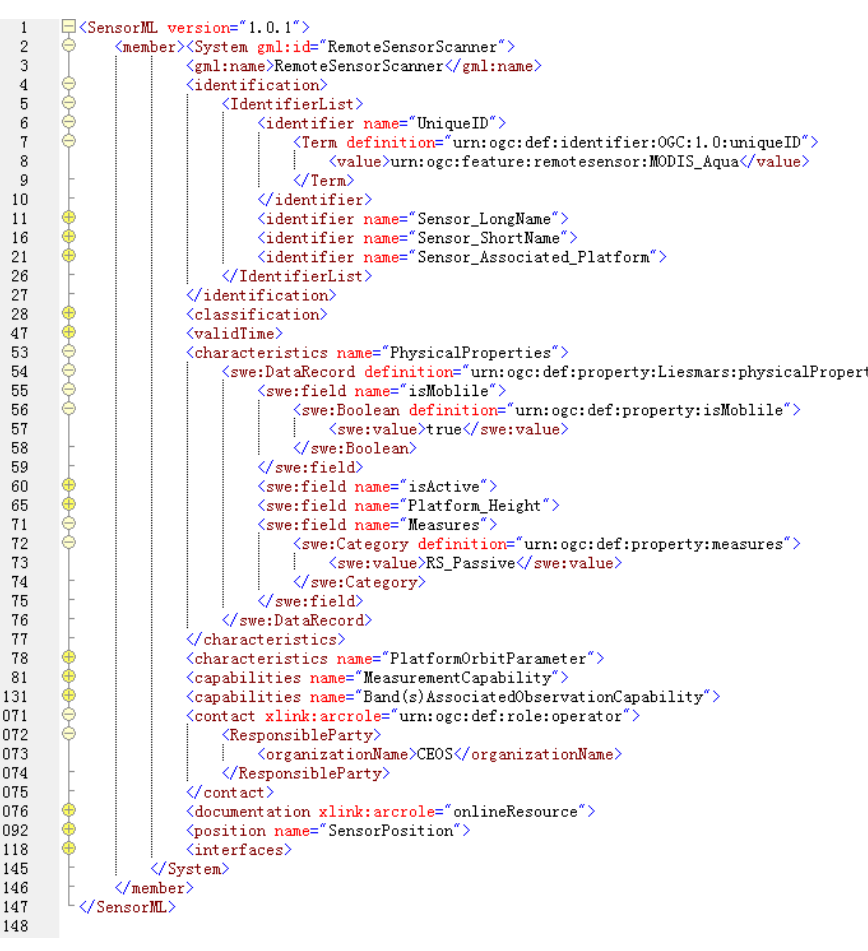
Figure 3. Sample of AQUA_MODIS SRO_rs